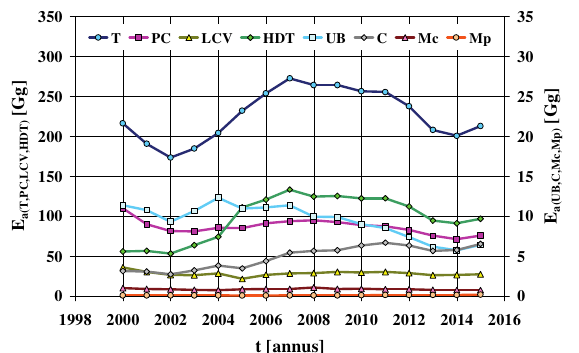
Fig. 12. National annual emission of methane per cumulated vehicle category